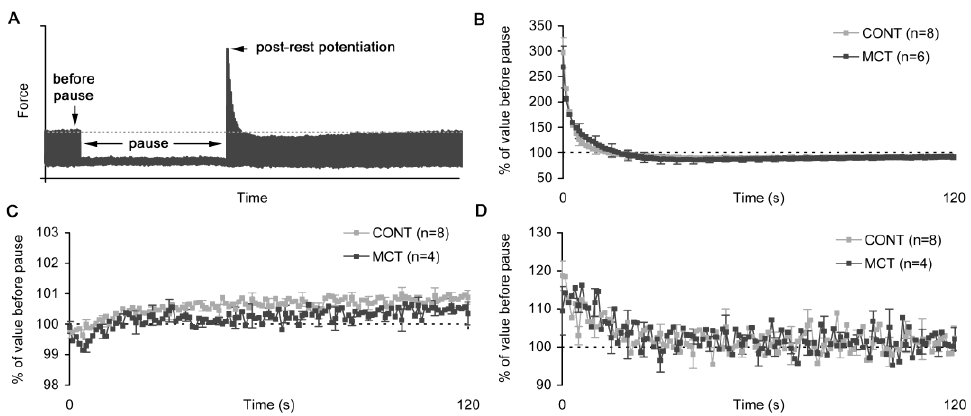
Figure 8. The effect of a pause in the stimulation (resting period) on the post-rest potentiation in the isometric twitch and Ca transient diastolic level and amplitude in the right atrial strip of control (CONT) and monocrotaline-treated (MCT) rats. ( A ) Representative plot of the post-rest potentiation of isometric twitches after a pause in the stimulation. Dotted lines show the “no effect” level. ( B ) The amplitude of the active force. ( C ) Ca transient diastolic level. ( D ) Ca transient amplitude. All values are shown as a % of the value measured before pause. The number of atrial strips is indicated in the legends. Data shown as mean ± S.D. All measurements were done for the preload of 95% L MAX at 30 °C and a 2 Hz pacing rate.